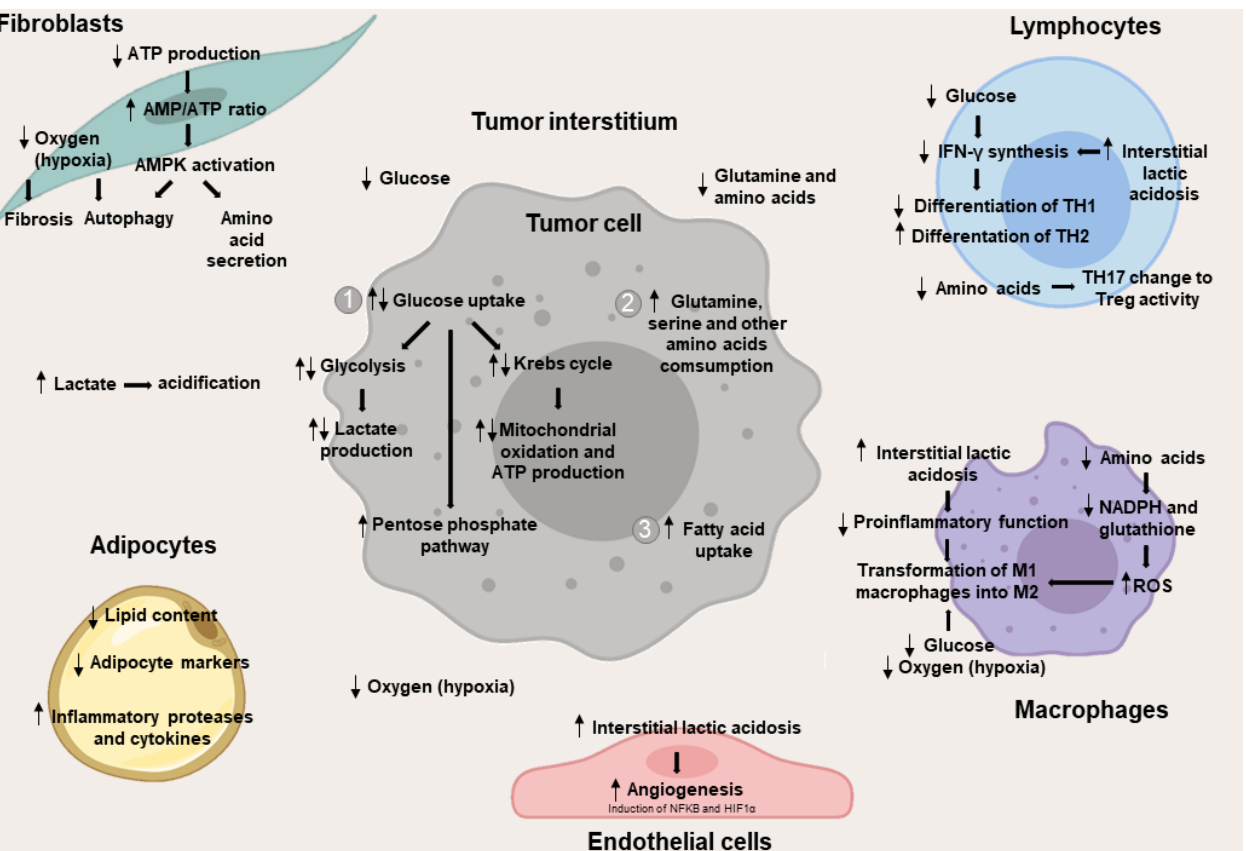
Figure 2. Resume of the metabolic changes taking place in tumor cells and interstitial cell subpopu- lations. Lactate is released into the interstitium, contributing to its acidification. The acidity and hypoxia of the interstitium and the relative deficit of glucose and amino acids induce functional changes in the various cell subpopulations of the interstitium, including myofibroblasts, endothelial cells, T lymphocytes, and macrophages, among others. All these changes mainly promote tumor growth. Upward pointing arrows indicate increased levels or activity of that molecule or pathway. The downward pointing arrows indicate the opposite. Created using BioRender.